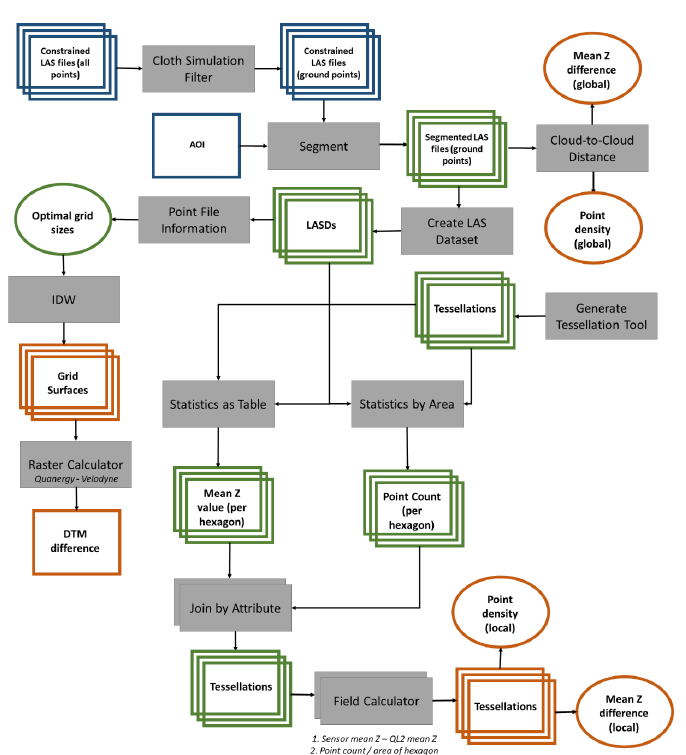
Figure 3. Workflow for tessellation comparative analysis using Quanergy M8, Velodyne HDL-32E, and North Carolina Quality Level 2 (QL2) LiDAR data; grey boxes indicate tools and operations, green squares indicate intermediate outputs from the di ff erent operations, dark blue boxes represent inputs including the constrained point clouds, and orange objects indicate final products, with squares indicating spatial data and ovals representing